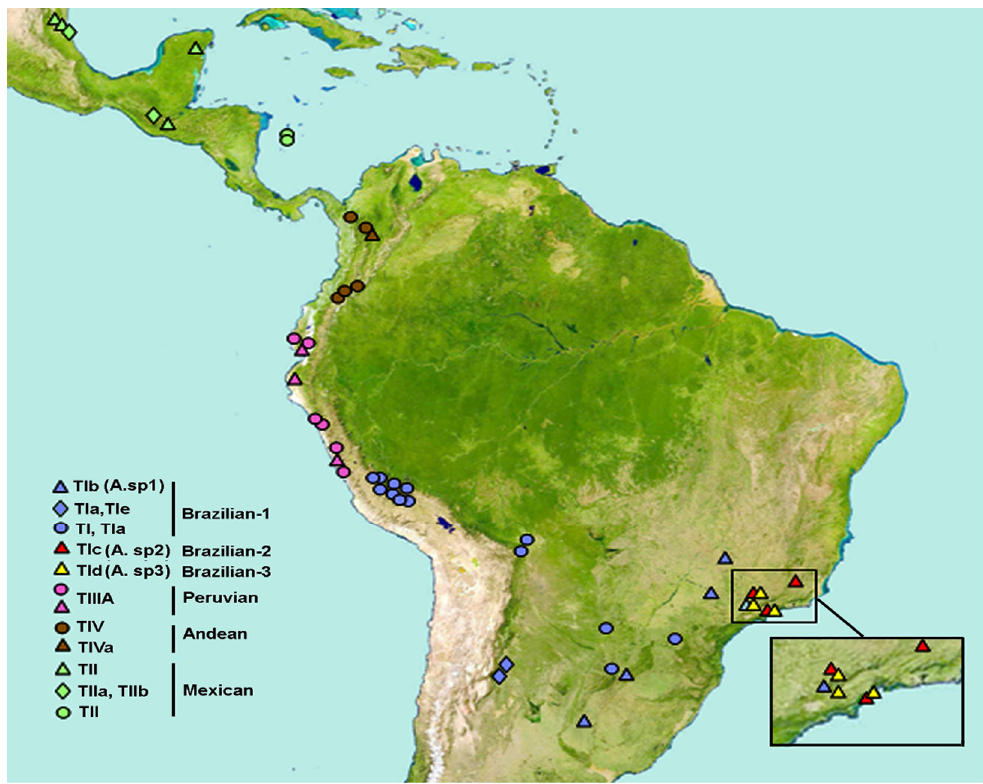
Figure 10. Approximate geographical location of Anastrepha fraterculus morphotypes and related ITS1 sequence types identified herein.